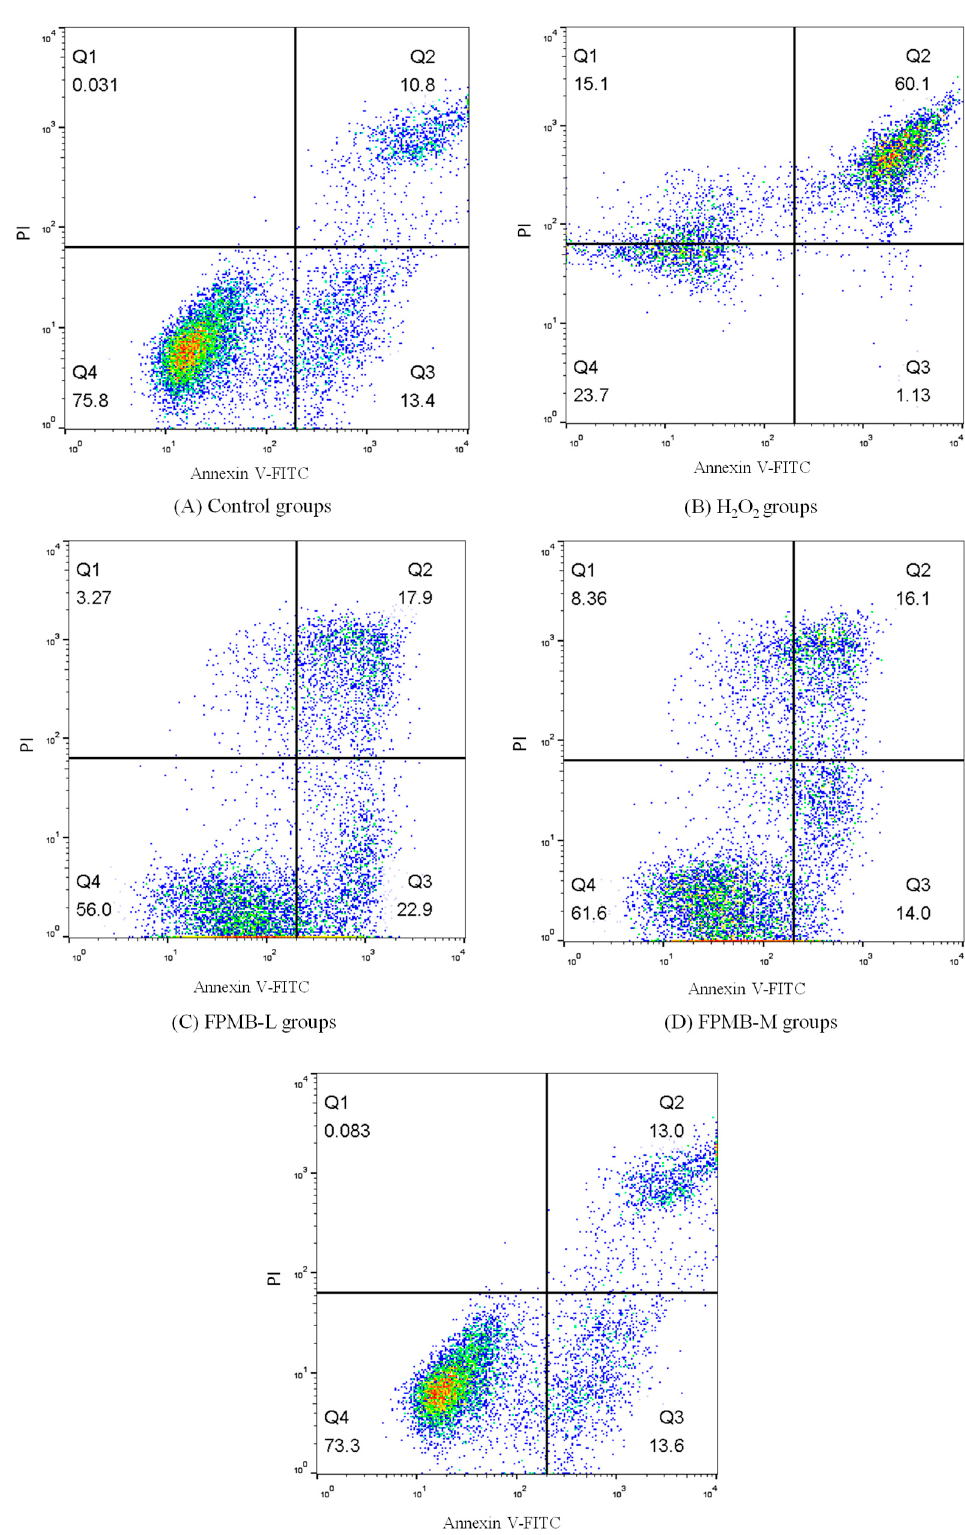
Figure 5. Effect of FPMB on the apoptosis of mice cardiomyocytes injured by H 2 O 2 . ( A ) Control groups; ( B ) H 2 O 2 groups; ( C ) FPMB-L groups; ( D ) FPMB-M groups; ( E ) FPMB-H groups.